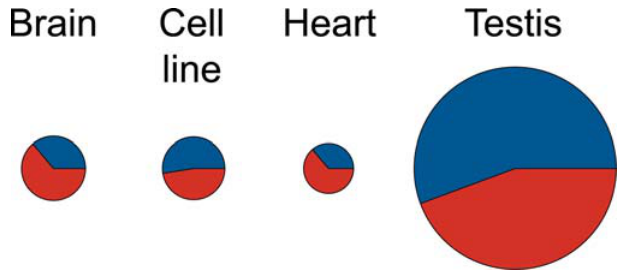
Figure 7. Proportions of Exonic and Intergenic Probes with Significant Expression Difference between Humans and Chimpanzees The colors indicate the proportions of exonic (blue) and intergenic (red) probes. The figure represents an average of the probe numbers identified as differently expressed on the positive and on the negative strands. The size of the circles reflects the number of probes. DOI: